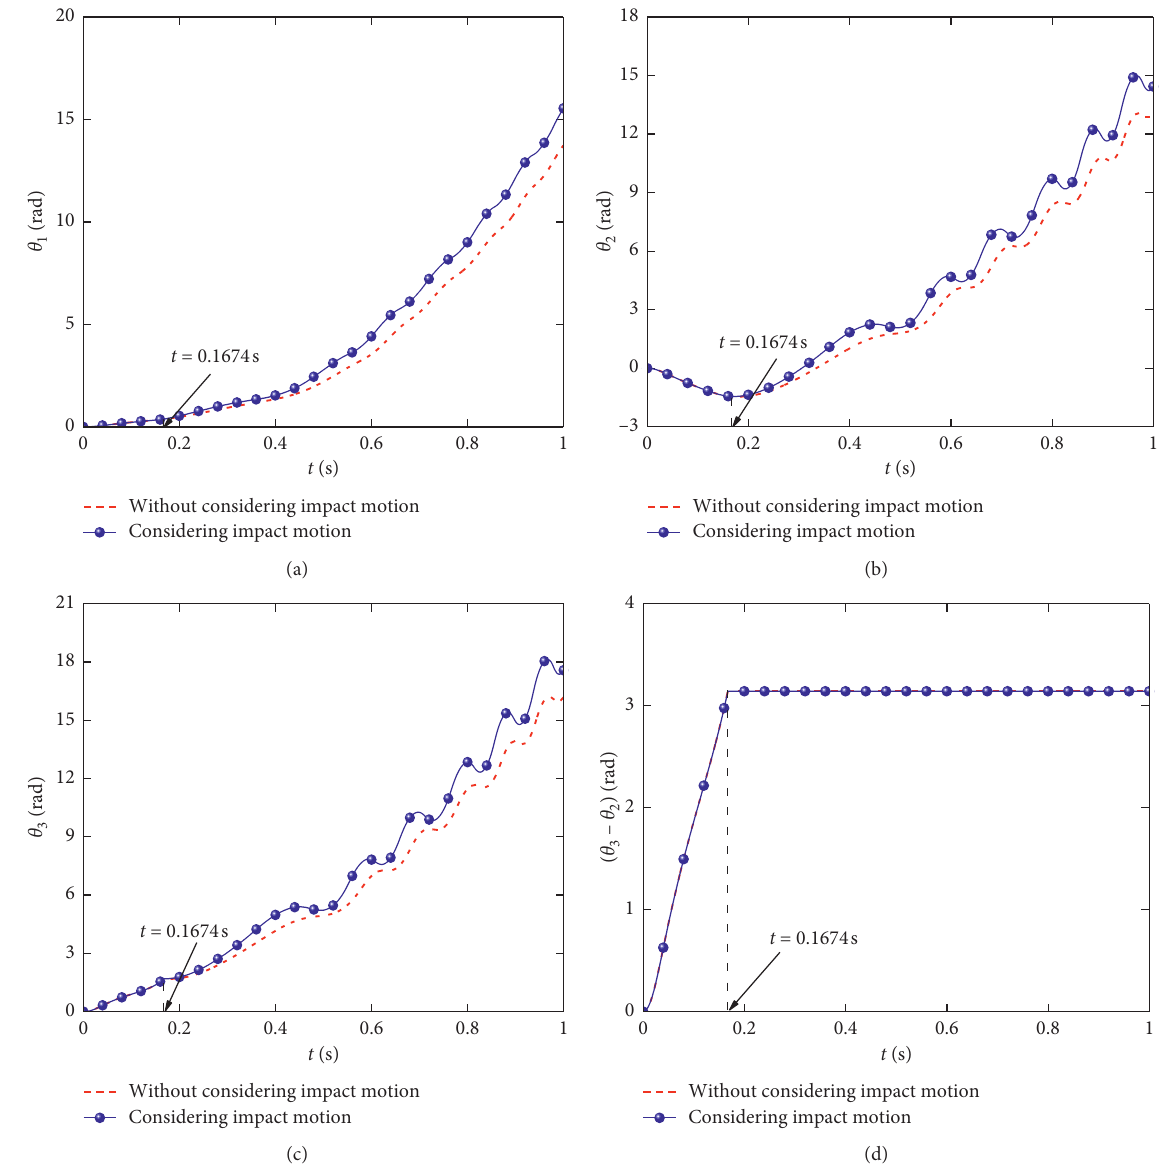
Figure 6: Angular displacement simulations. (a) Variation in the angle of component 1. (b) Variation in the angle of component 2. (c) Variation in the angle of component 3. (d) Angle variation of component 3 relative to